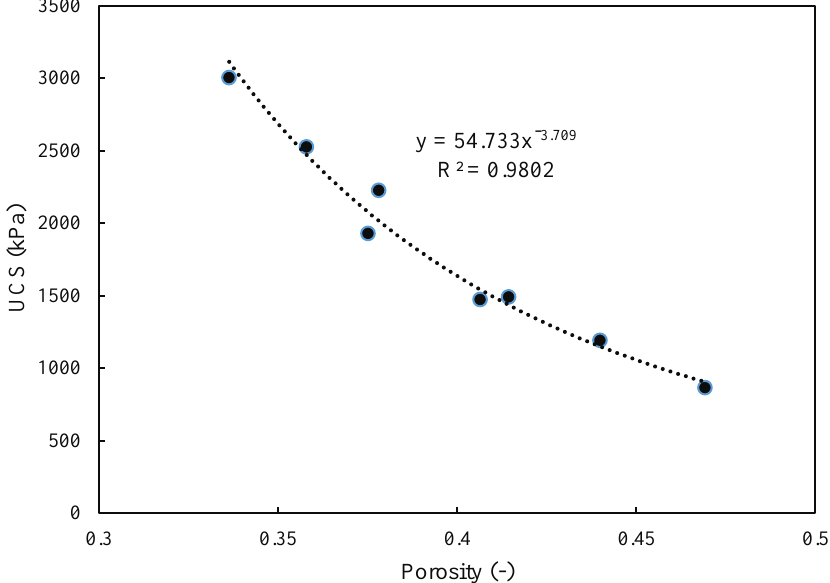
Figure 12. Relationship between porosity and compressive strength of FS30 and FS70 geopolymer-stabilized specimens.